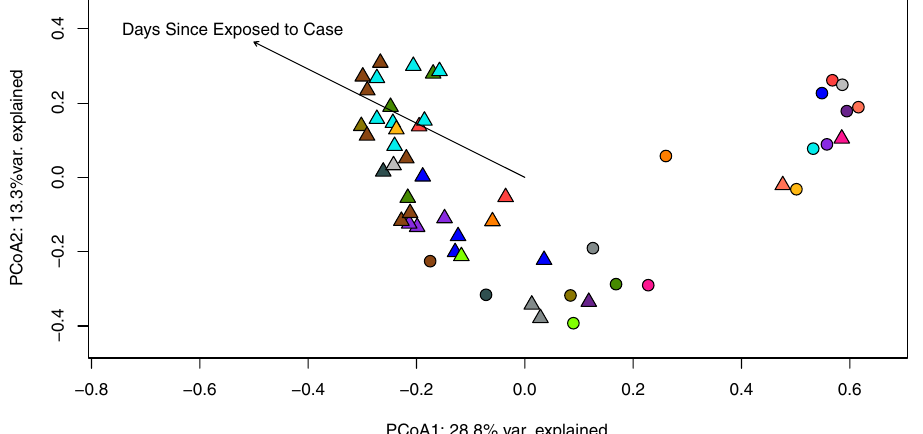
Figure 9. Beta diversity analyses do not reveal clear similarities among 16 separate families as seen in a Principal coordinates analysis (PCoA) plot generated using Bray–Curtis dissimilarity of all samples. Case samples are depicted as circles and controls as triangles; members of the same family are represented by the same color. Environmental factors with potential to influence this ordination were also examined. The variable exploring the number of days since exposure to the case was significantly correlated with the observed ordination. These data were fitted to the ordination using the ‘envfit’ function in R and displayed with a labeled arrow in the plot. The number of days since exposure to an ill family member is correlated to more “normal” looking controls (i.e., controls that are most dissimilar from their corresponding infected